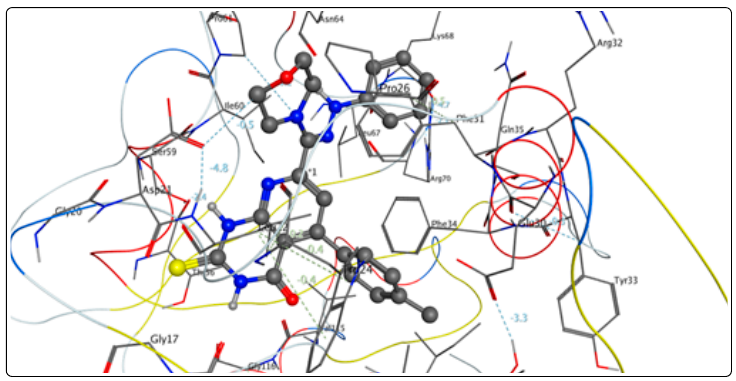
Figure 3. The interesting compound 7b fitted into the enzyme pocket by interacting with amino acids found in the pocket.